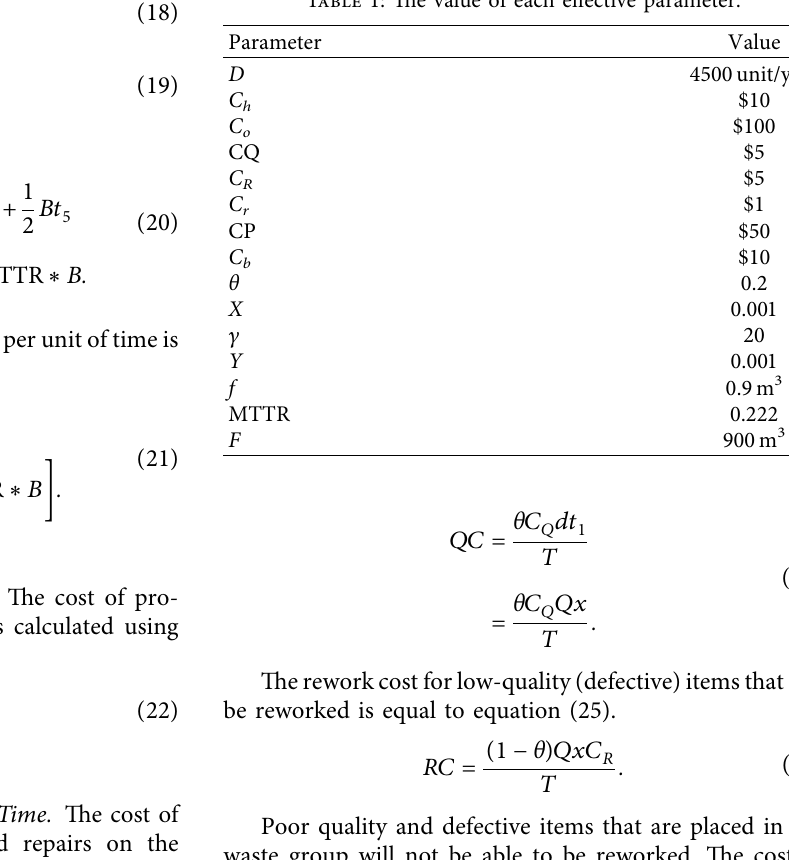
Figure 3: Shortage level. Table 1: Te value of each efective